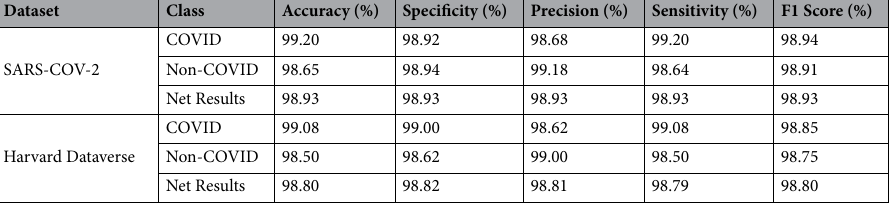
Table 4. Results obtained by the proposed ensemble framework on the test sets of both SARS-COV-2 and Harvard Dataverse datasets.